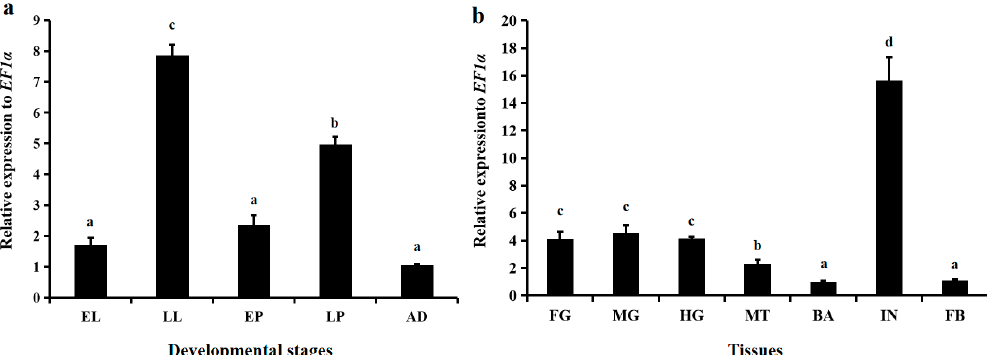
Figure 3. The spatiotemporal expression patterns of LsNAG2 in Lasioderma serricorne . ( a ) The relative expression levels of LsNAG2 in different developmental stages. EL, early larave; LL, late larvae; EP, early pupae; LP, late pupae; AD, adults. ( b ) The relative expression levels of LsNAG2 in different tissues including integument (IN), brain (BA), fat body (FB), foregut (FG), midgut (MG), hindgut (HG), and Malpighian tubules (MT). Elongation factor 1-alpha (EF1 α ) was used as the reference control. Lowercase letters above bars indicate statistical difference based on one-way ANOVA followed by a least significant difference test ( p < 0.05).